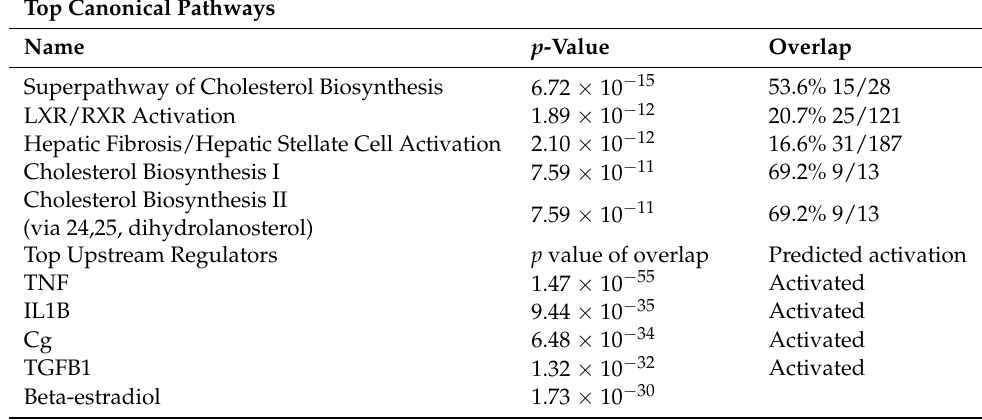
Table 1. Ingenuity Pathway Analysis of gene expression in HAA1 cells. Summary of Analysis- HAA1 for Ingenuity.